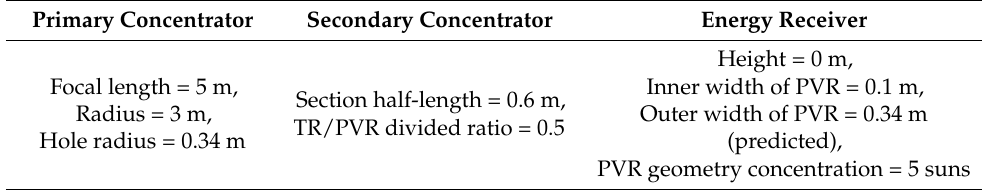
Table 1. Structural parameters of TFSC for ray-tracing simulations.